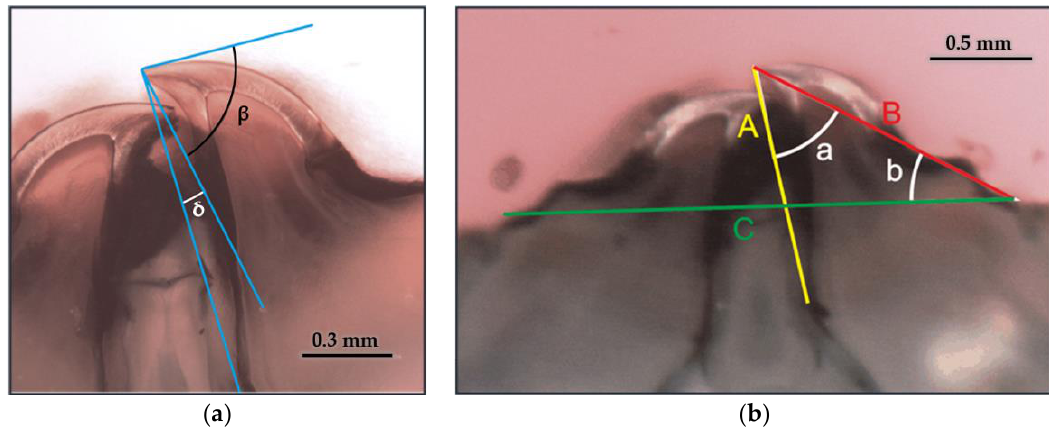
Figure 11. Distances and angles: ( a ) Jaw wedge angle β = 77.3 ° and the angle between segment A and the rake face c = 9.6°; ( b ) A = 1249 µm is the distance between cutting edge and insertion of the adductor, B = 1496 µm is the distance between the cutting edge and the articulation axis radius of rotation of the jaw, C = 2539 µm is the joint distance, a = 44.8° is the angle between segments A and B and b = 30.9° is the declination angle between segments B and C.